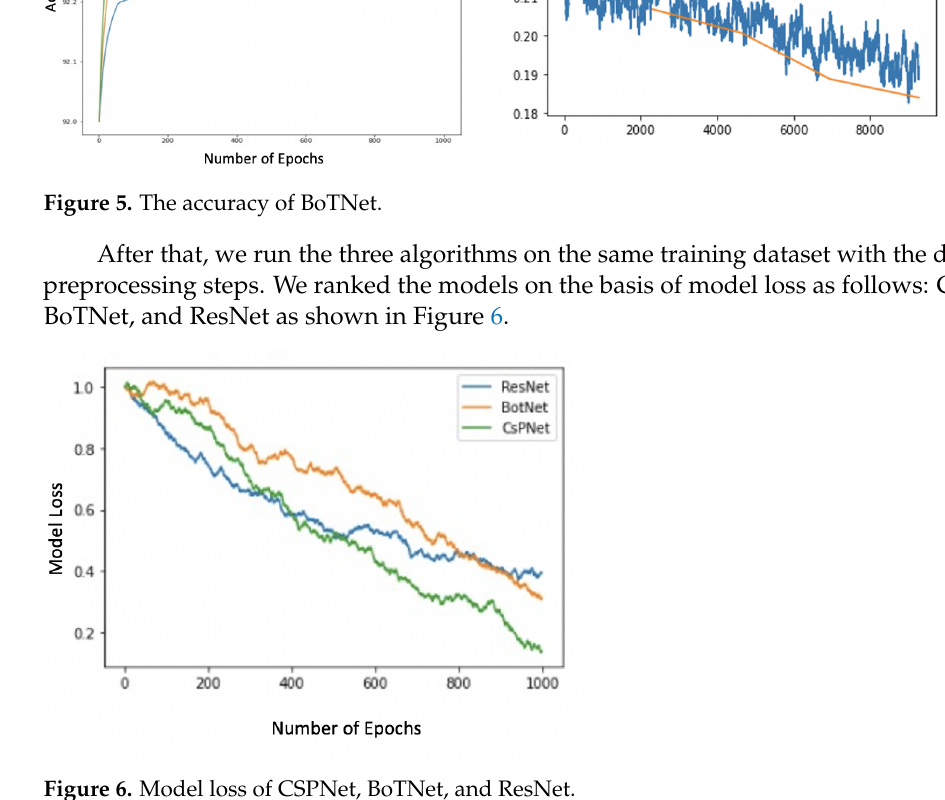
Figure 6. Model loss of CSPNet, BoTNet, and